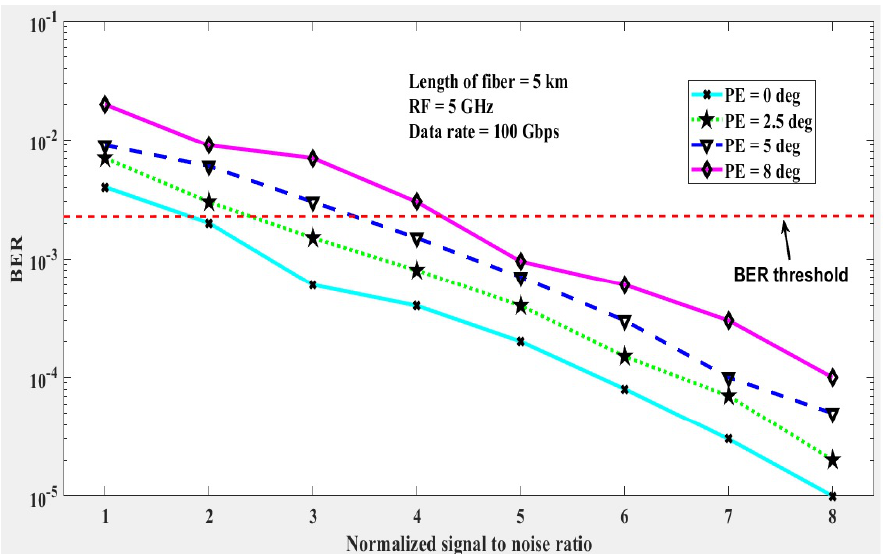
Figure 4. Normalized signal to noise ratio against BER for 0, 2.5, 5 and 8 deg phase errors (PEs) at 5 km of path cover.